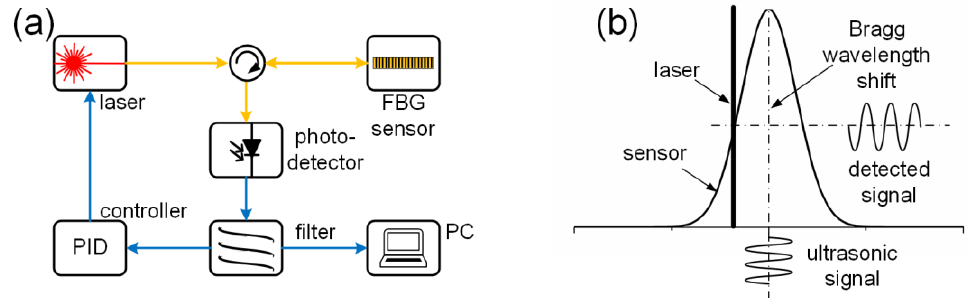
Figure 5. The FBG demodulation systems using a laser light source. ( a ) The schematic diagram of the system setup; ( b ) the detection principle.